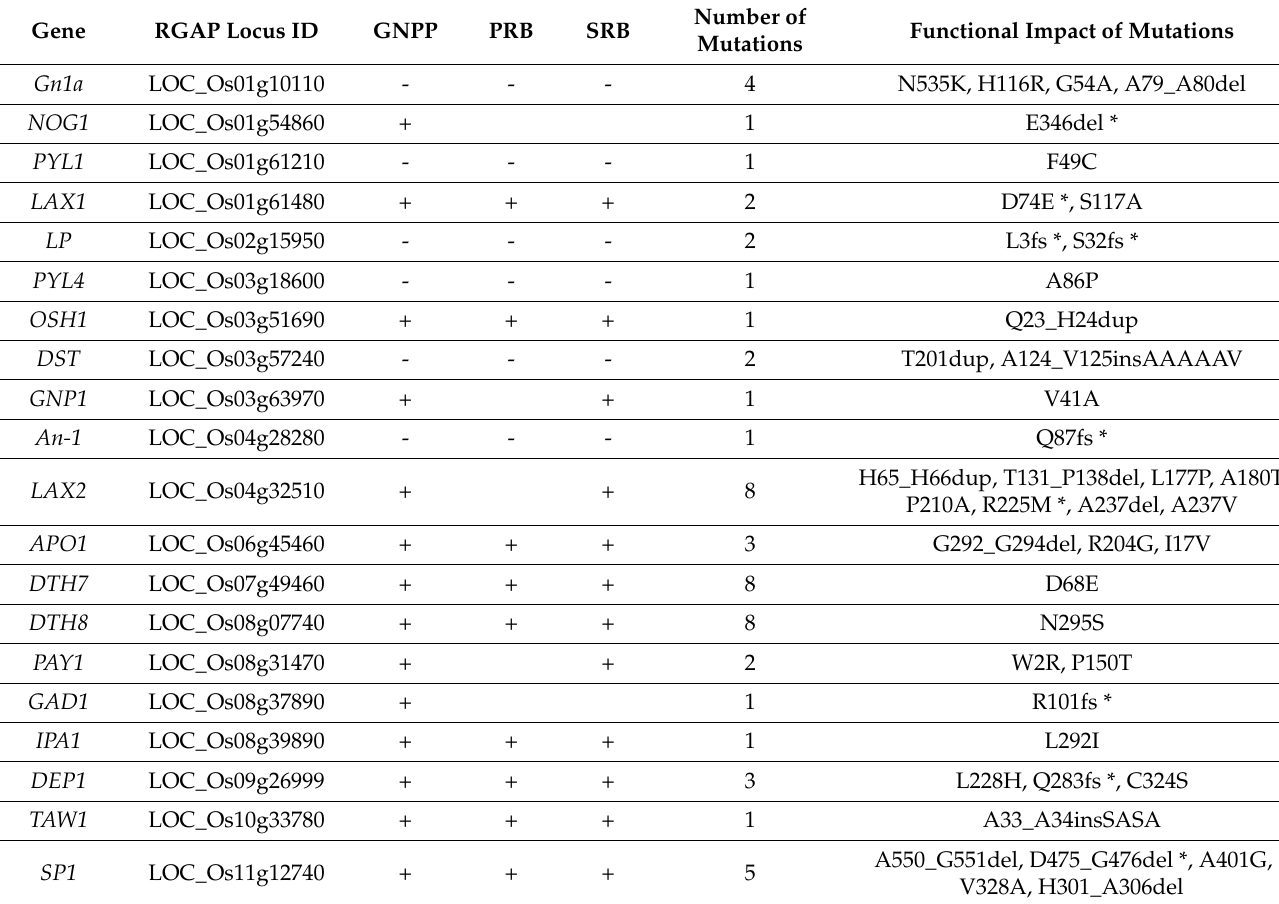
Table 1. Details for differences in the known genes related to the grains number per panicle between LH9 and RPY in